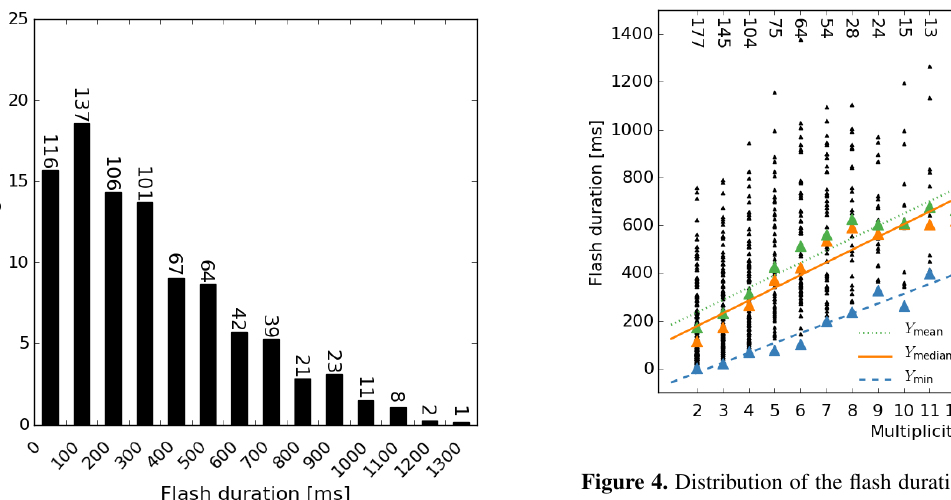
Figure 4. Distribution of the flash duration as a function of multi- plicity. The equation for the minimum, median and mean regression is given as well as the correlation coefficient of 0.96, being similar for all three regressions. The actual number of flashes per multiplic- ity is indicated at the top of the